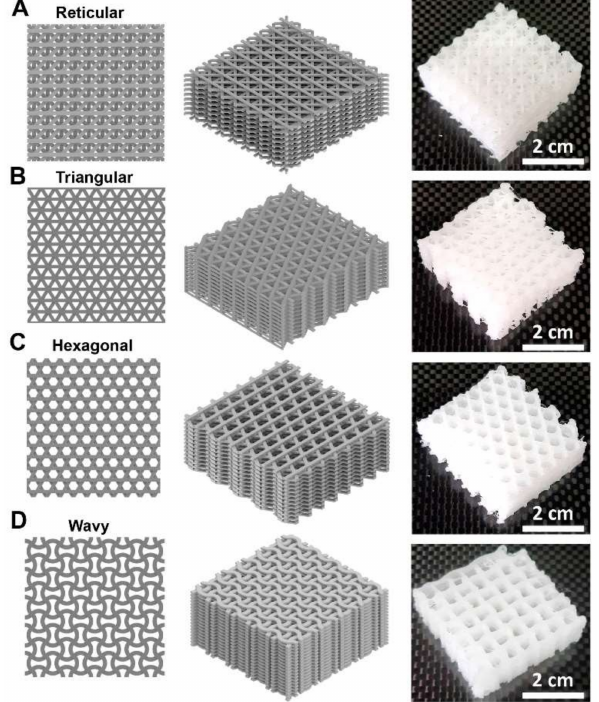
Figure 1. CAD models of designed lattice structures. ( A – D ) Top and 3D views of CAD design of four types of lattice geometries ( A ) reticular, ( B ) triangular, ( C ) hexagonal, and ( D ) wavy and related images of the 3D printed